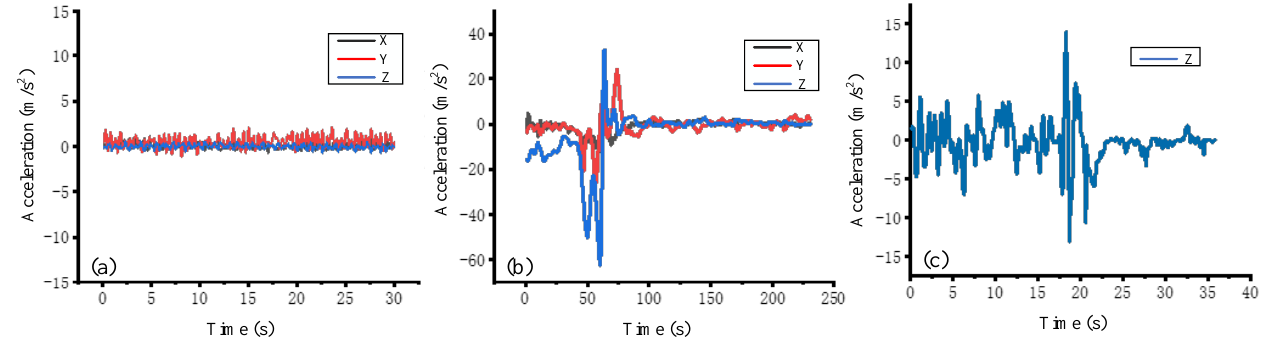
Figure 11. External interaction perception based on acceleration. ( a ) The hand maintains static or move at a uniform speed. ( b ) Collision with obstacles located in the Y and Z axes. ( c ) The change in Z-axis acceleration when the object is being placed on the table.